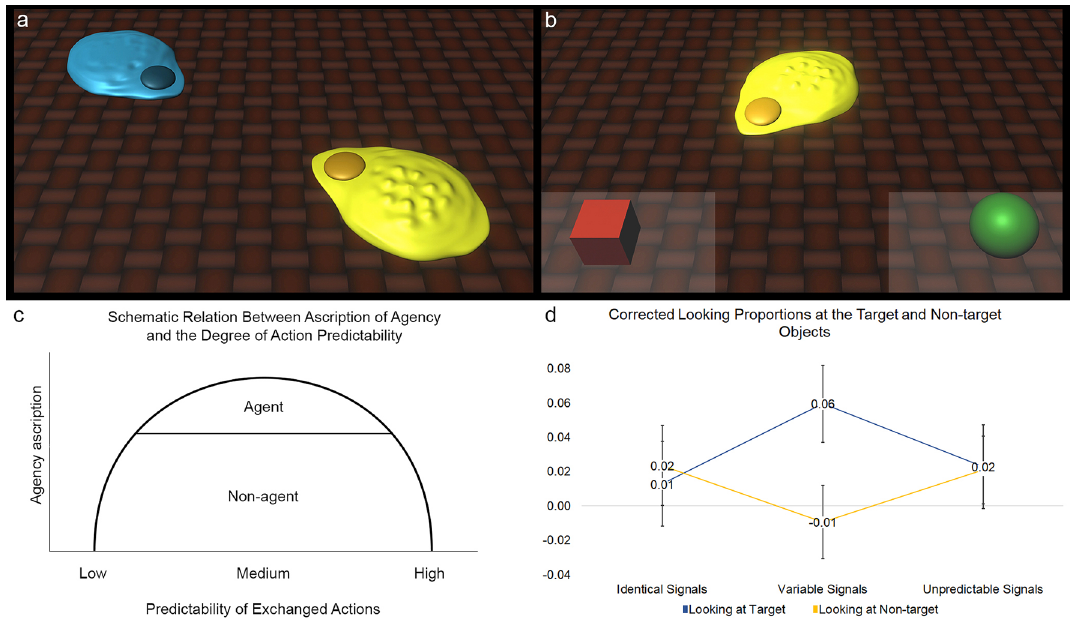
Figure 1. ( a ) Entities exchanging signal sequences in the familiarization phase, ( b ) entity orients toward the target referent in the test phase (light grey areas indicate ROIs around the objects), ( c ) hypothesized relation between predictability of exchanged actions and agency ascription, ( d ) baseline-corrected and log-transformed looking time proportions at the target and non-target object in the three